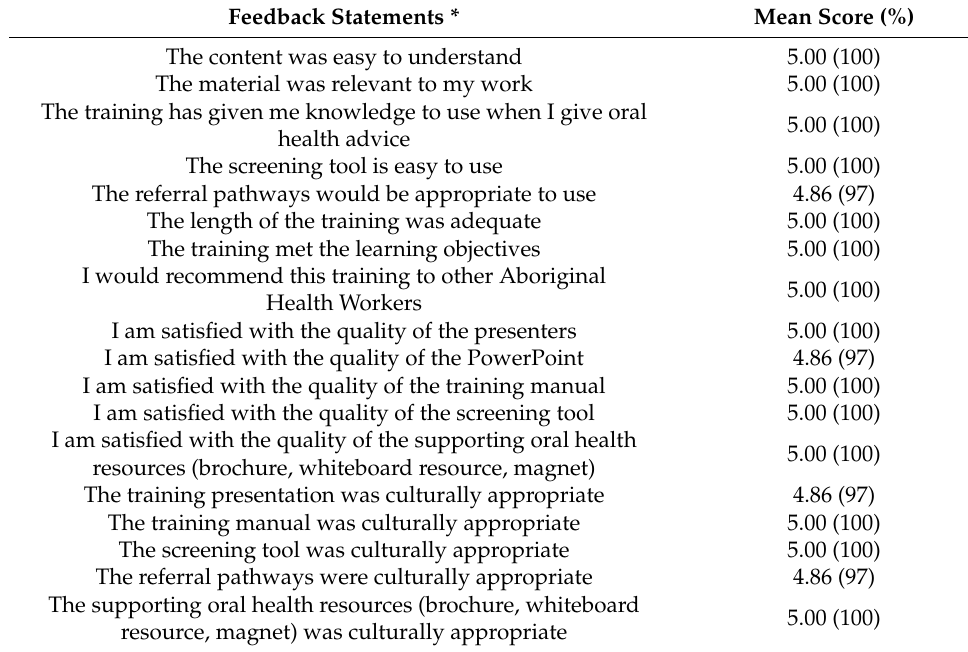
Table 2. Likert agreement to post-training feedback